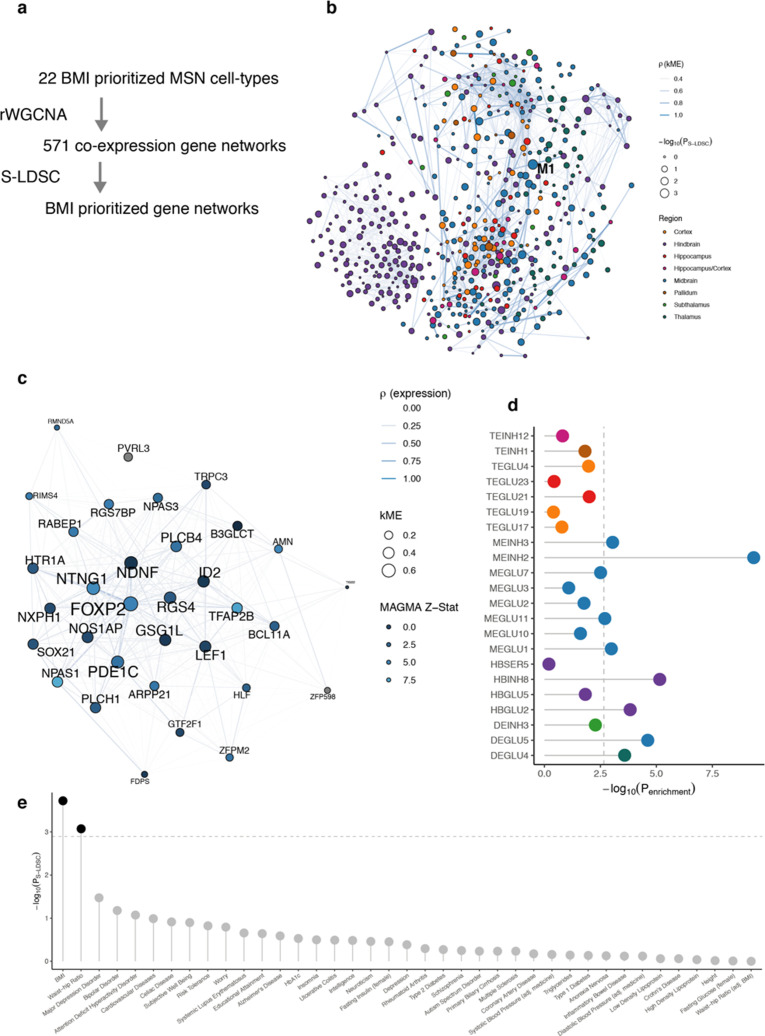
Genetic prioritization of cell type gene co-expression networks.(a) Overview of our approach to identify and prioritize cell type gene co-expression networks (modules). We used robust weighted gene correlation network analysis (rWGCNA) to identify gene modules on expression data from individual BMI-prioritized cell types. The resulting modules were used as input to S-LDSC for genetic prioritization. (b) Network visualization of the 571 cell type gene modules. The graph shows the absolute Pearson’s correlation (ρ, edge width) between modules (nodes). Node color indicates the region of the cell type from which the module originates; node sizes represent genetic prioritization P-value for BMI (-log10(PS-LDSC)). The M1 module (originating from the MEINH2 cell type) is highlighted as the top significant module. The M1 module is not highly correlated with other modules. Only edges with ρ>0.3 are shown. (c) Network visualization of the M1 gene module. The graph shows the absolute Pearson’s correlation (ρ, edge width) between genes (nodes) in the module. Node size indicate kME value (a measure of gene-module membership); node color indicates MAGMA BMI gene Z-statistic (an aggregated measure of nearby variants BMI association). (d) Enrichment of M1 module genes in BMI-prioritized cell types. Genes in the M1 module are enriched among expression specific genes for multiple prioritized cell types, but most strongly in MEINH2. The dashed line indicates the Bonferroni significance threshold (Penrichment <0.05/22). (e) Genetic prioritization of M1 module across multiple GWAS traits. The M1 module is associated with BMI and waist-hip ratio (passing Bonferroni significance threshold PS-LDSC <0.05/39). Weighted gene correlation network analysis results for each of the 22 BMI-enriched cell types are available in Figure 3—source datas 5 and 6.